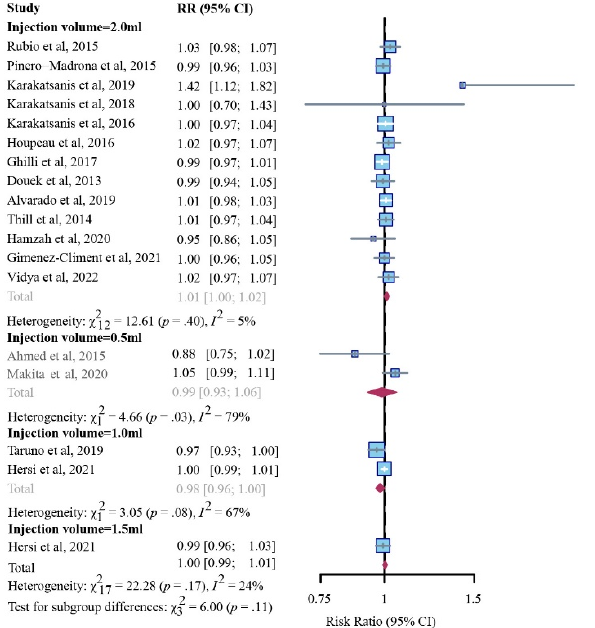
Figure 3. Subgroup analysis of patient identification rates for SPIO versus standard method (fixed- effects model), stratified through baseline injection volumes of 0.5 mL, 1.0 mL, 1.5 mL, or 2.0 mL.